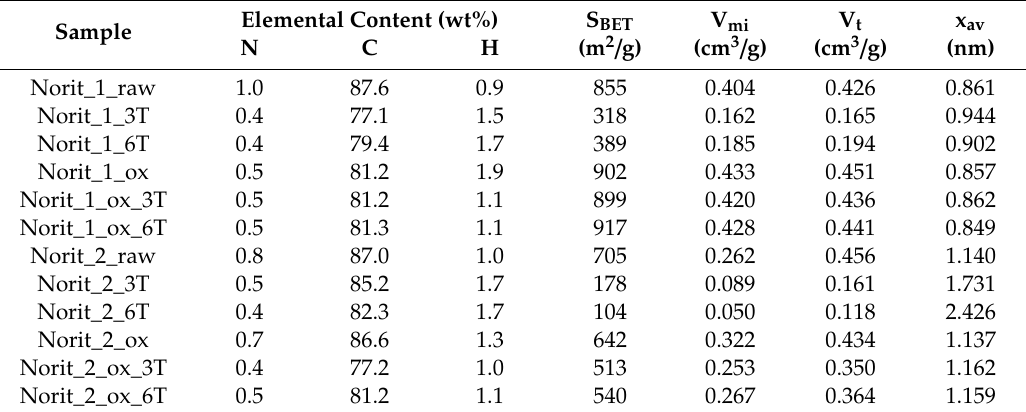
Table 1. Chemical composition and structural parameters of the Norit and hybrid materials. Elemental Content Sample